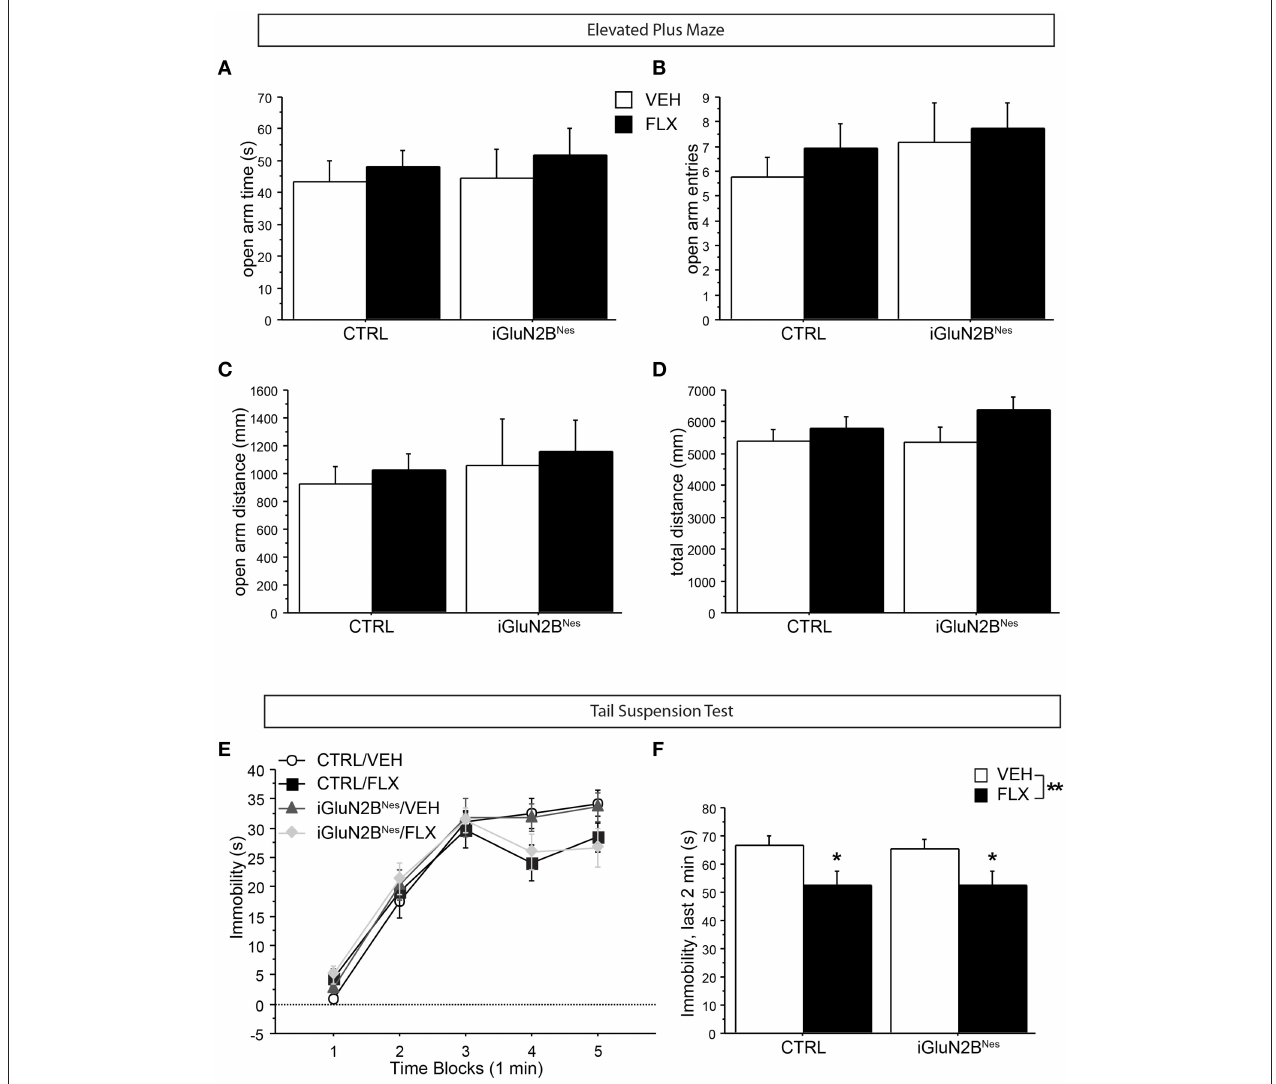
FIGURE 3 | GluN2B deletion did not impact anxiety-related behavior in the EPM, nor did it affect FLX’s ability to lower immobility in the TST. In the EPM, no difference among groups was observed in open arm exploration as measured by (A) time spent in the open arms, (B) number of open arm entries, or (C) distance traveled in the open arms. (D) The total distance traveled in the maze did not differ among groups. (E) In the TST, VEH-treated mice display increasingly higher levels of immobility as the test progresses, while FLX reduced immobility over time. (F) GluN2B deletion did not impact FLX’s ability to lower immobility during the last 2 min of the test. * p < 0.05, ** p <